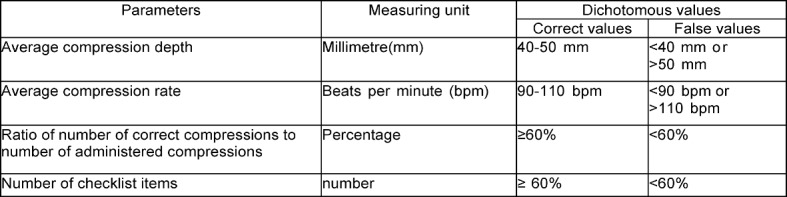
CPR target value